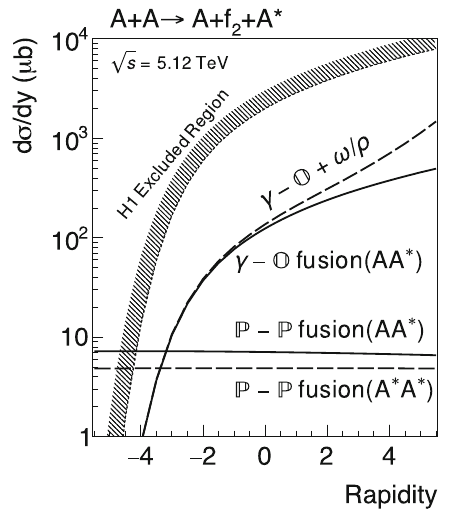
Fig. 1 Indicative predictions for the photon- and Pomeron-induced cross sections for the (incoherent) process AA → A + f 2 + A ∗ as a √ s NN = 5 . 12 GeV. In this plot the f 2 function of the f 2 rapidity for absorptive cross section σ tot ( f 2 N ) in the heavy ion is calculated from (17)with σ 0 = 15 . 7 / 2mband (cid:10) = 0 . 055.Thedashedcurvefor ( A ∗ A ∗ ) is shown only because this process serves as a possible background to the Pomeron-induced ( AA ∗ ) contribution. The shaded band indicates the region predicted to be excluded for the Odderon signal if we were to use the upper limit for σ(γ p → f 2 p ) of 16 nb found at HERA [52], rather than 1